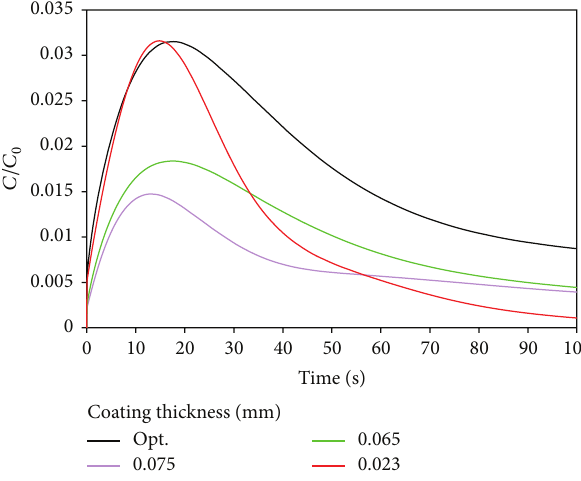
Figure 7: Influence of coating thickness on drug concentration into the artery